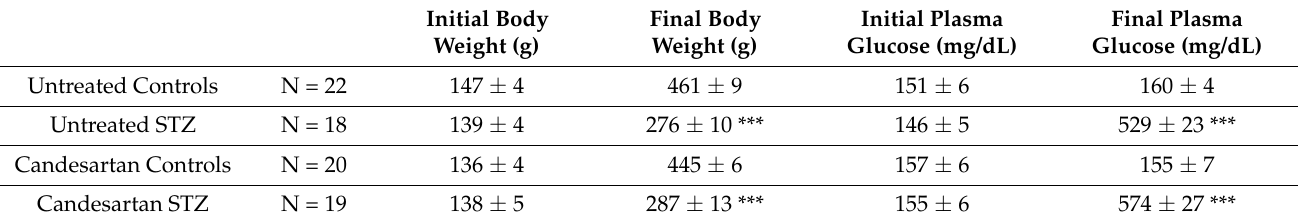
Table 2. Body weight and plasma glucose